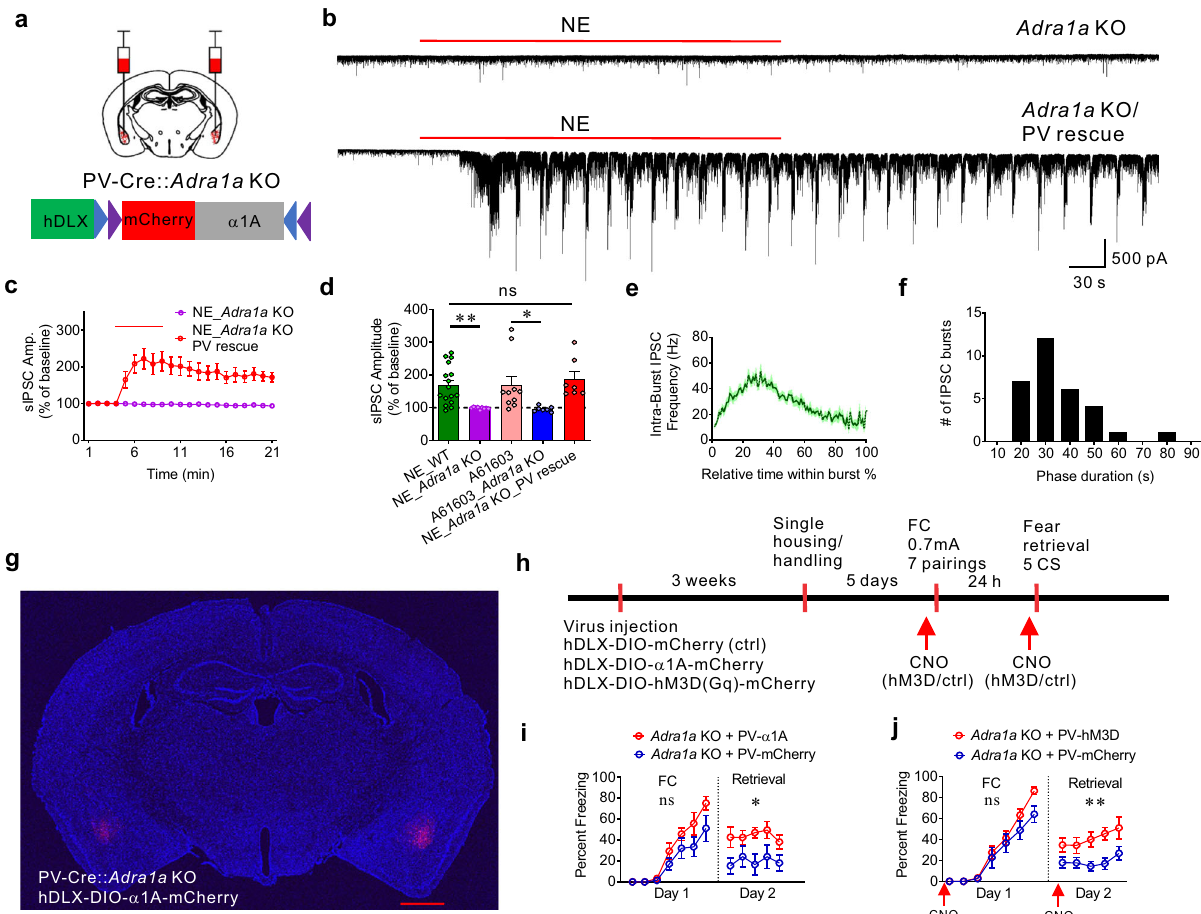
Fig. 8 Rescue of α 1A adrenoreceptor and Gq signaling in BLA PV interneurons in a global α 1A receptor knockout ( Adra1a KO) mouse facilitates fear memory formation. a Schematic of the BLA injection sites in PV-Cre:: Adra1a KO mouse and AAV viral vector containing the fl oxed α 1A, mCherry, and hDLX promoter. b Representative traces showing loss of NE-induced IPSC bursts in principal neurons from Adra1a KO mouse (top) and recovery following replacement of Adra1a selectively in PV interneurons (bottom). c NE effect on sIPSC amplitude (mean ± SEM) in principal neurons from Adra1a KO mice with or without re-expression of Adra1a in PV interneurons over time ( n = 7 and 9 cells from 3 and 4 mice, respectively). d Mean (±SEM) changes in sIPSC amplitude in response to NE or the α 1A agonist A61603 in principal neurons from wild-type (WT) and Adra1a KO mice. Adra1a re-expression in PV interneurons restored NE facilitation of sIPSC amplitude in BLA principal neurons (NE-WT, n = 16 cells from fi ve mice; NE- Adra1a KO, n = 9 cells from 4 mice; A61603-WT, n = 10 cells from 4 mice; A61603- Adra1a KO, n = 7 cells from 3 mice; NE- Adra1a KO-PV rescue, n = 7 cells from 3 mice) (Unpaired t - test (two-tailed), A61603-WT vs. A61603- Adra1a KO: p = 0.039) (One-Way ANOVA, F(2, 29) = 7.43, p = 0.0025; Dunnett ’ s multiple comparisons test, NE-WT vs. NE- Adra1a KO: p = 0.0046, NE-WT vs. NE- Adra1a KO-PV rescue: p = 0.68). e Mean instantaneous intra-burst IPSC frequency over the course of the burst, showing rescued IPSC bursts display an accelerating intra-burst frequency similar to WT mice (31 bursts from 7 cells, 3 mice). f Distribution of phase duration of NE-induced IPSC bursts following BLA Adra1a rescue in Adra1a KO mice (31 bursts from 7 cells, 3 mice). g α 1A-mCherry expression after bilateral virus injections. Scale bar = 1 mm. h Timeline of virus injection, fear conditioning, CNO injections in PV-Cre:: Adra1a KO mice. CNO (5 mg/kg, I.P.) was administrated 30 min before fear acquisition and before fear retrieval (red arrows). i Adra1a replacement in BLA PV interneurons in Adra1a KO mice had no effect on fear acquisition ( n = 11 and n = 10 Adra1a KO mice with expression of α 1A adrenoreceptors and mCherry in BLA PV interneurons, respectively, Mean ± SEM, Two-Way repeated measures ANOVA, F(1, 19) = 3.49, p = 0.077), but facilitated retrieval of the fear memory (Mean ± SEM, Two-Way repeated measures ANOVA, F(1, 19) = 6.92, p = 0.017). j Rescue of Gq signaling with excitatory DREADD in BLA PV interneurons from Adra1a KO mice had no effect on fear memory acquisition ( n = 11 and n = 9 Adra1a KO mice with expression of hM3D and mCherry in BLA PV interneurons, respectively, Mean ± SEM, Two-Way repeated measures ANOVA, F(1,18) = 2.15, p = 0.16 compared to Controls), but enhanced fear memory retrieval (Mean ± SEM, Two-Way repeated measures ANOVA, F(1,18) = ;11.17, p = 0.0036). ** p < 0.01, * p < 0.05, ns not signi fi cant. Source data are provided as a Source Data fi le. interneurons via hM3D-Gq and α 1A adrenoreceptors generated a In contrast to the canonical electrophysiological property of PV highly stereotyped phasic bursting pattern of activity that drove interneurons to fi re sustained high-frequency action potentials repetitive, synchronized bursts of IPSCs and spikes in post- upon depolarization, we observed repetitive bursts of action synaptic BLA principal neurons. Gq-DREADD and α 1A receptor potentials in PV interneurons in response to α 1A and hM3D activation in BLA PV neurons decreased gamma oscillatory receptor-induced Gq activation. The PV neuron phasic bursting power. Finally, BLA PV-Gq signaling enhanced retrieval of was dependent on a postsynaptic intrinsic Gq signaling auditory cue-conditioned fear memory, consistent with the sup- mechanism, and not mediated by local circuits or depolarization- pression of BLA gamma oscillations. induced activation, since it was not suppressed by blocking NATURE COMMUNICATIONS| (2022) 13:1290